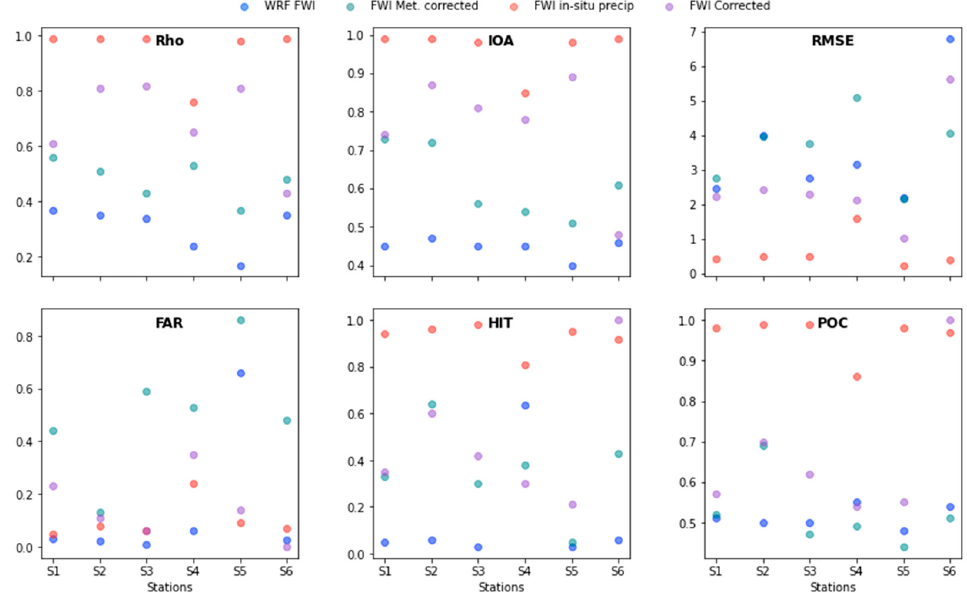
Figure 6. Statistical evaluation of the model performance for the FWI for the selected 160 days (Section 2). The blue circles represent the statistics of the WRF model before any correction. Dark cyan circles show the FWI calculated with the meteorological corrected variables. Red circles indicate the FWI calculated with the meteorological corrected variables and the observed precipitation. Purple circles show the FWI directly corrected by the WRF-1D .